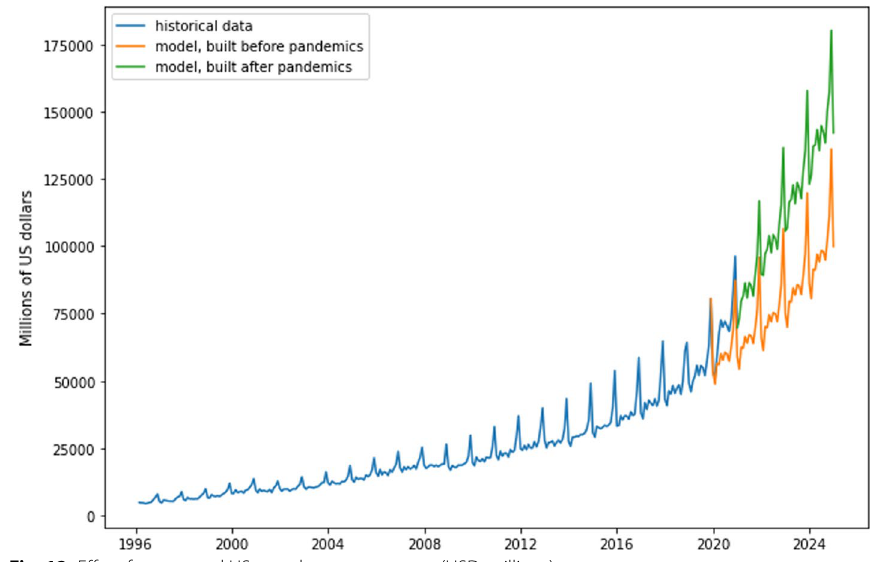
Fig. 12 Effect forecast and US e-trade sector revenue (USD, millions)